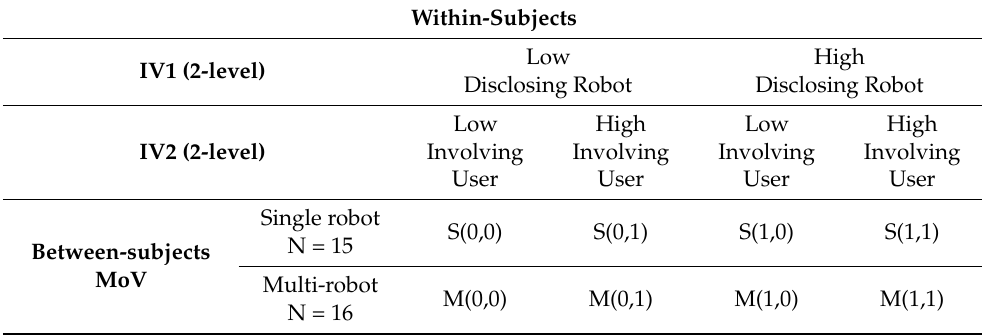
Table 2. Experimental design and number of participants in between-subject